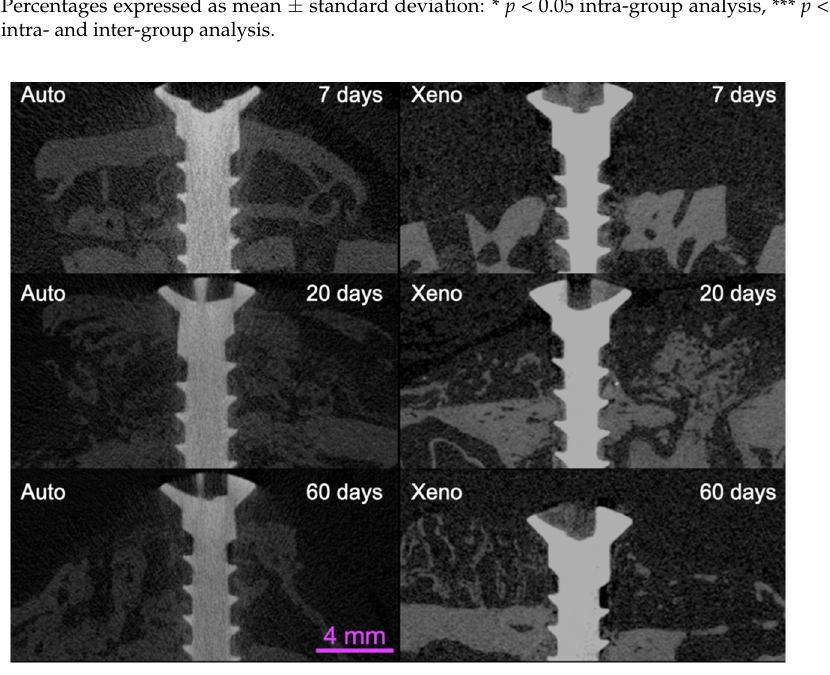
Figure 4. Cross-sectional microtomographic images of the autogenous (control) and xenogenous (test) groups showing the volumetric changes of the grafts after 7, 20 and 60 days of healing.